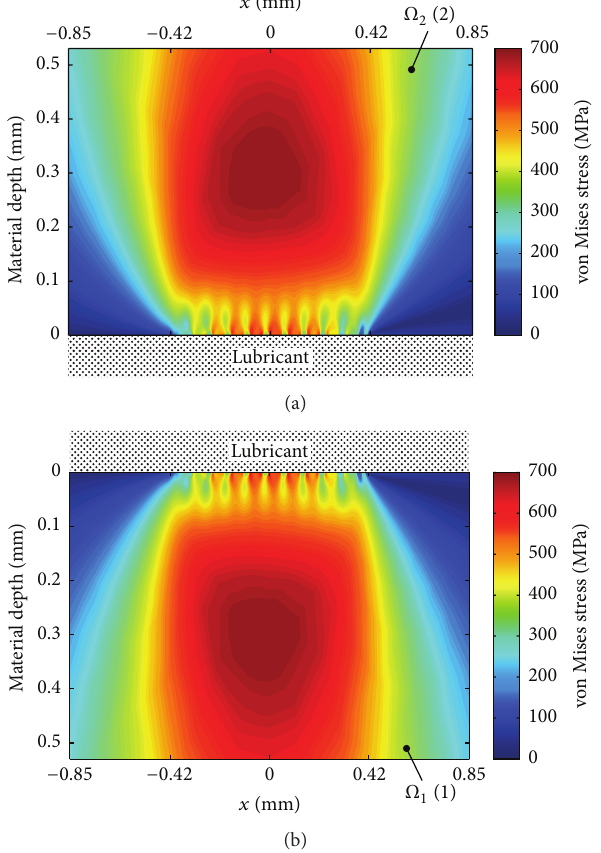
Figure 10: von Mises stress in the lower solid body (a) and in the upper solid body (b) correlating to Figure